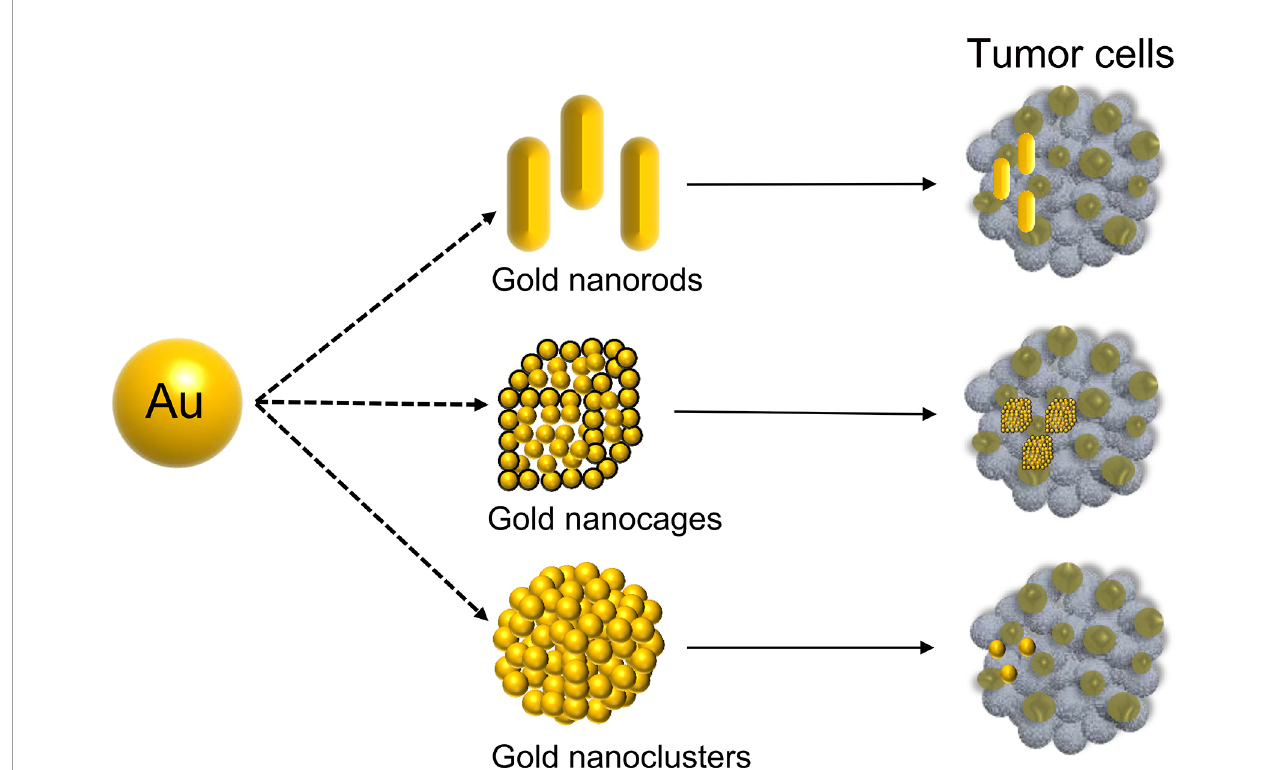
FIGURE 1 | Different shapes of